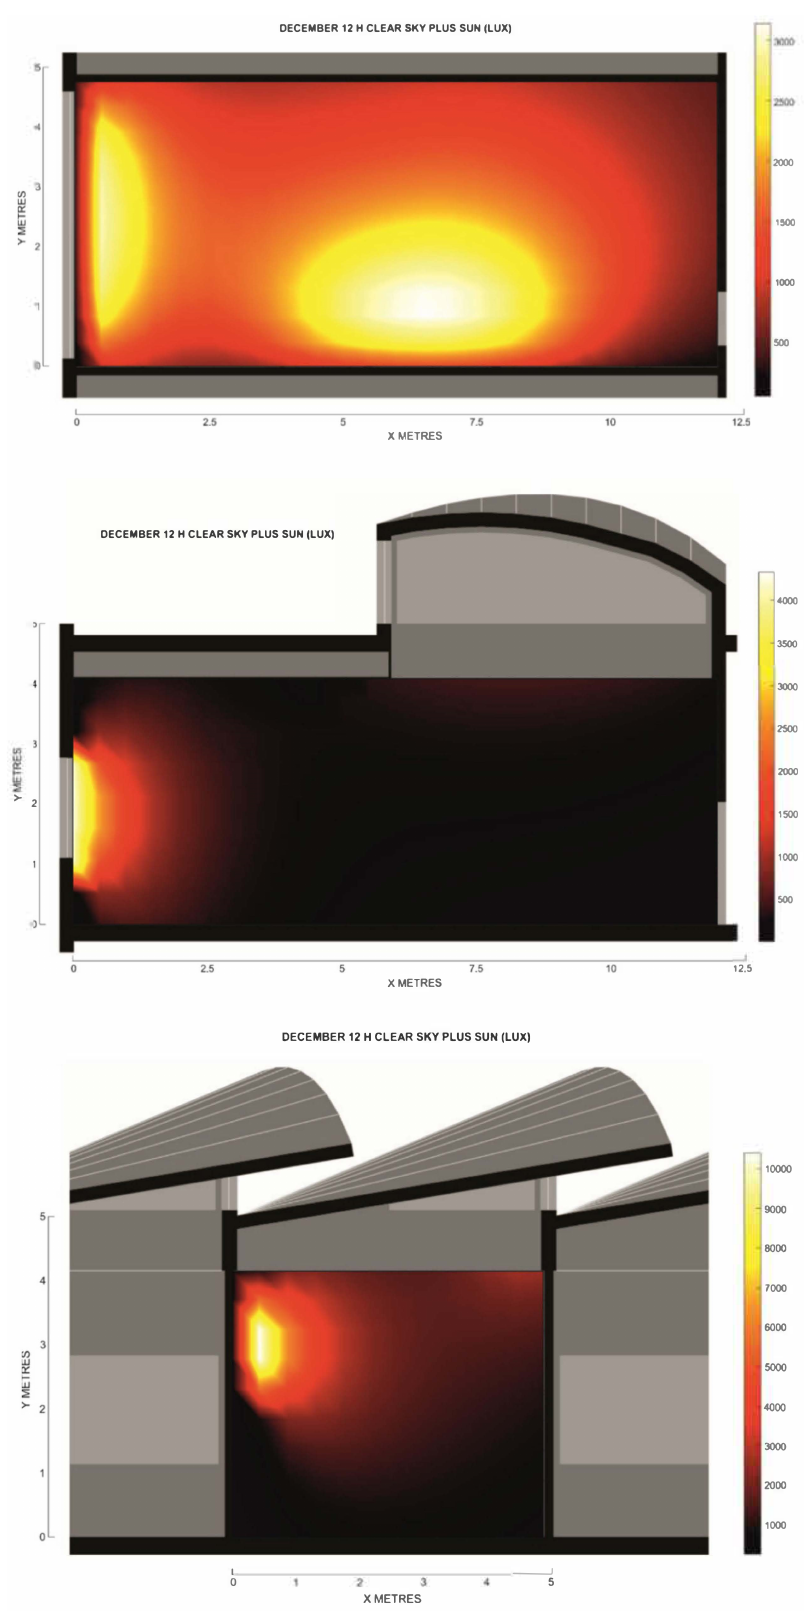
Figure 11. The horizontal and vertical illuminance distribution in an office. December 12:00 h solar time, clear sky plus sun. Values in lux. Source: the